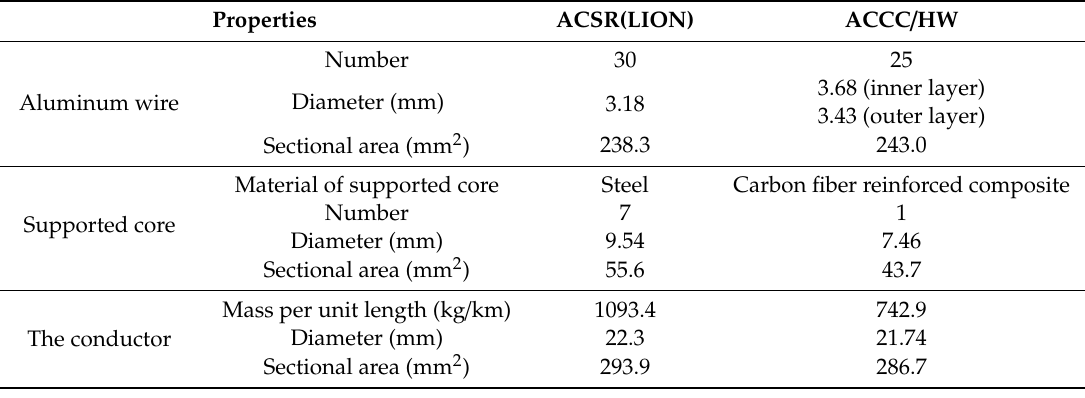
Figure 2. Conductor configuration of ACSR. Table 2. Main structural parameters of ACCC / HW and ACSR of the similar specification.